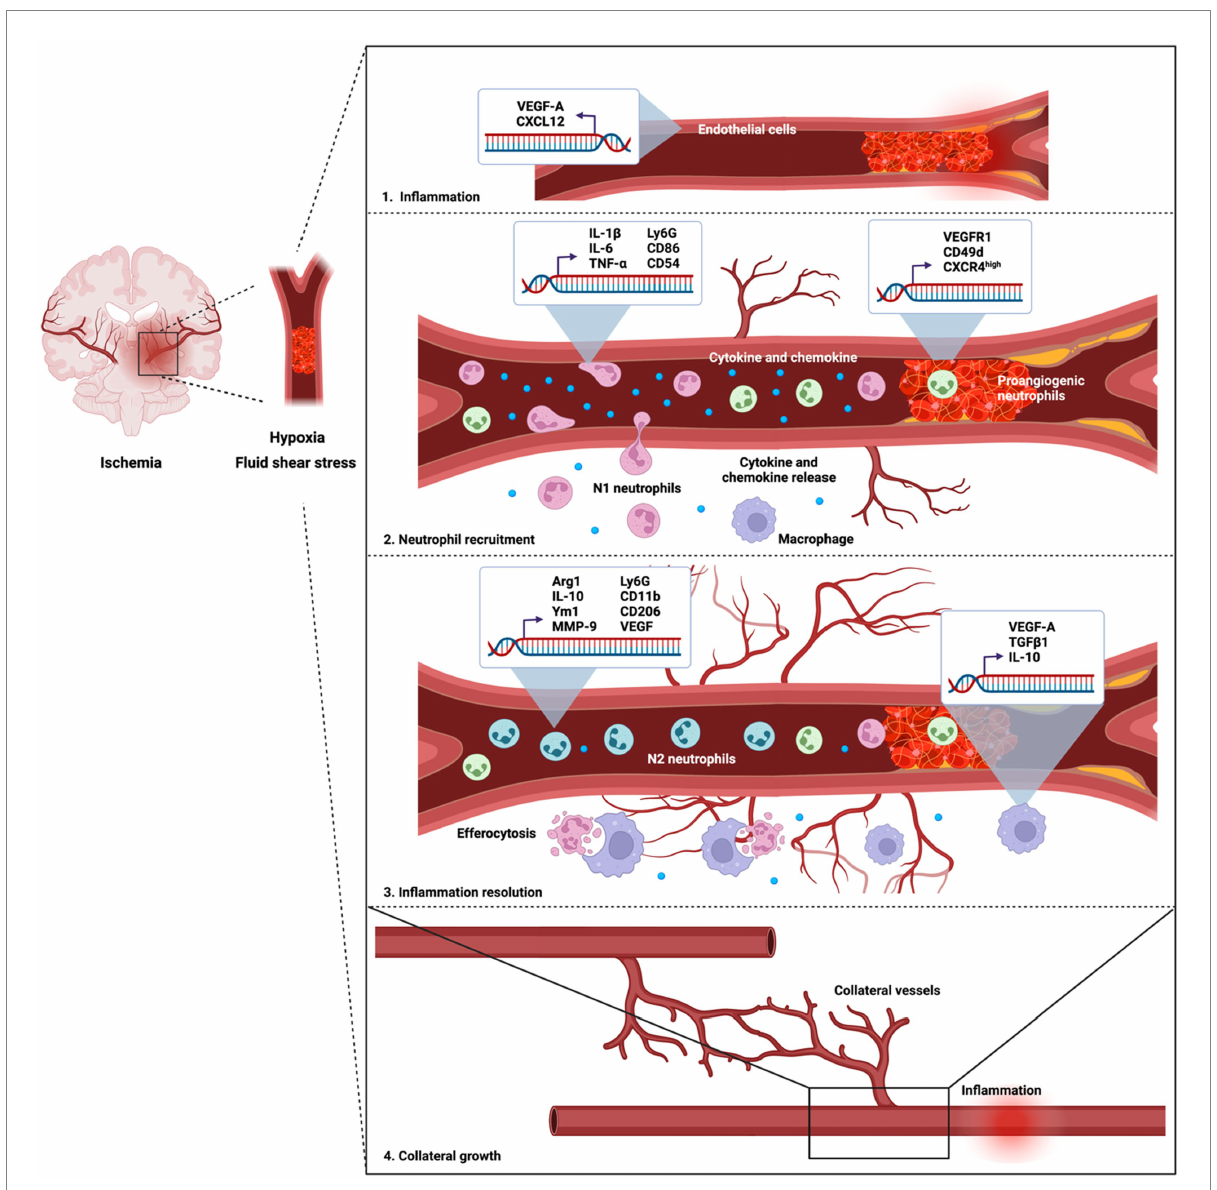
FIGURE 3 Different subpopulations of neutrophils have distinct effects on collateral growth and angiogenesis post-ischemia. Angiogenesis post-ischemia stimulates the growth of new collateral vessel conduits, which helps partially perfuse the tissues and sustain tissue viability until recanalization and reperfusion. Middle cerebral artery occlusion is depicted with collateral vessel growth post-ischemia. Three subtypes of neutrophils, pro- inflammatory N1, protective N2, and pro-angiogenic neutrophils are recruited to the inflammatory site post-IS in response to hypoxic stimuli and fluid shear stress. During ischemic injury, hypoxic genes, including VEGF-A, CXCL12, and DAMPs are upregulated. VEGF-A is overly expressed in endothelial cells, which recruit N1 neutrophils and pro-angiogenic neutrophils into the circulation. The later wave of recruitment consists of both pro-angiogenic and N2 neutrophils that initiate collateral development via MMP-9 release. This prompts collaterals recruitment from adjacent vascular arteries. Resolution of inflammation is completed by efferocytosis of neutrophils by